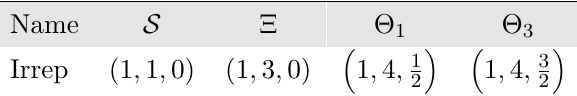
Table 2. Scalar “exits” that do not generate tree-level four-fermion operators. Symbols use the notation of [18]. The numbers in brackets refer to the representations of the SM gauge groups SU(3) , SU(2) and U(1) C L Y